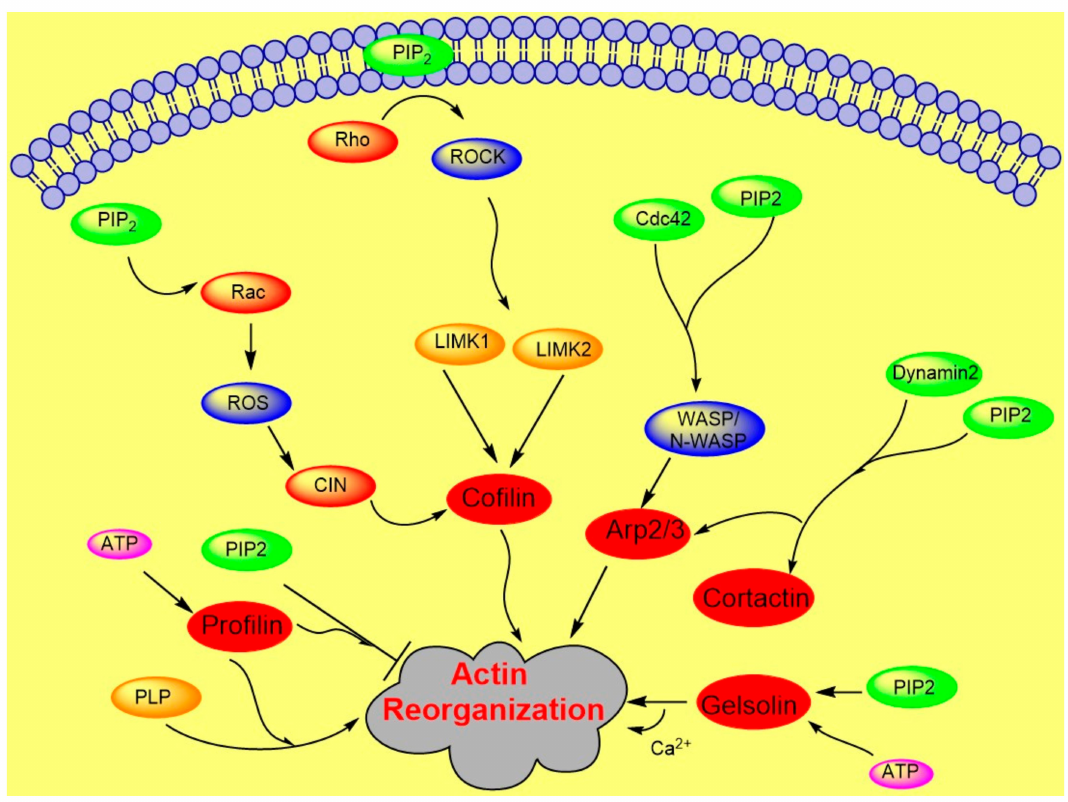
Figure 2. Role of PIP2 in actin dynamics either by promoting polymerization or inhibiting